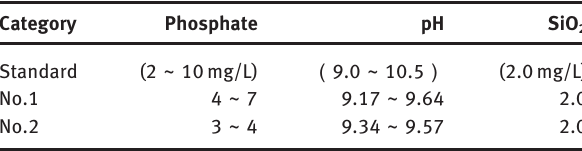
Table 3: Water quality analysis of the boiler water. Category